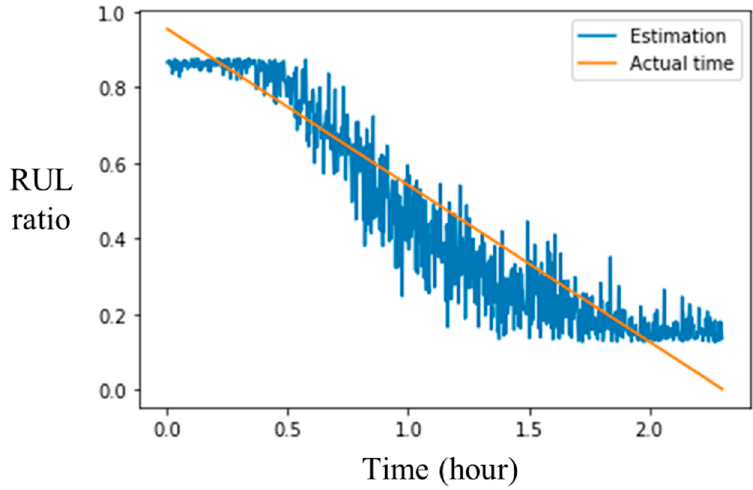
Figure 9. The continuous monitoring of the entire process data of the training set.